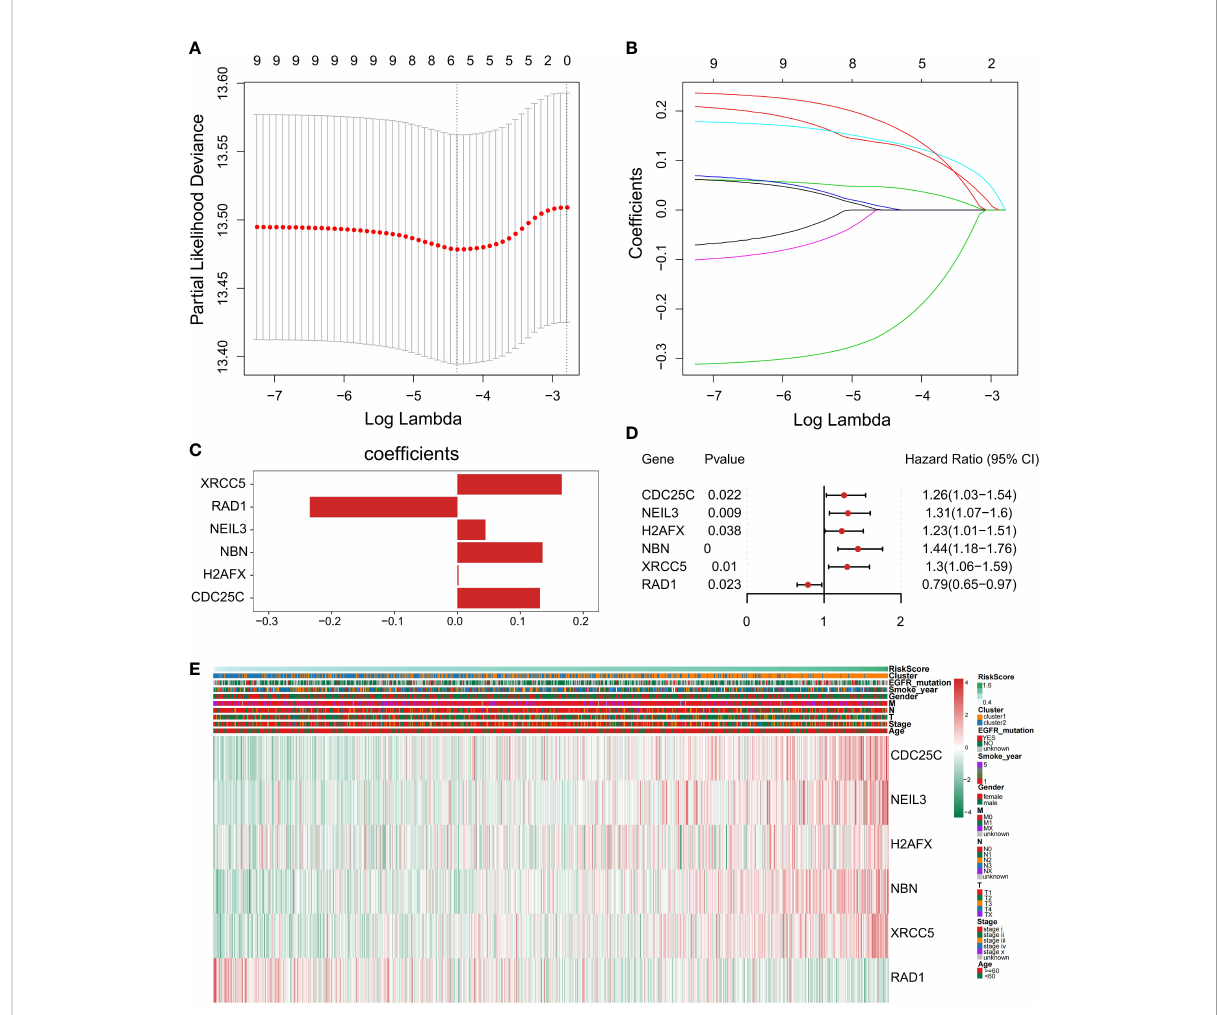
FIGURE 7 Construction of a prognostic-related signature by the LASSO regression model. (A) Selection of the optimal l -value through a 10-fold cross- validation. (B) The fi tting processes for LASSO Cox regression models were constructed from the six signature genes. The tuning parameter l was derived from the partial likelihood deviance with a 10-fold cross-validation, and the coef fi cient was plotted against Log( l ). The six gene signature was identi fi ed based on the best fi t pro fi le. (C) LASSO coef fi cient pro fi les of the six key prognostic DDR-related genes. (D) Forest plot of prognostic DDR ‐ related genes based on univariate Cox regression analysis. (E) The heatmap was scaled with the Z-Score using the log2 (FPKM+1) expression of signature genes. With the increase in the risk scores, CDC25C, NEIL3, H2AFX, NBN, and XRCC5 expression levels were upregulated and RAD1expression level was